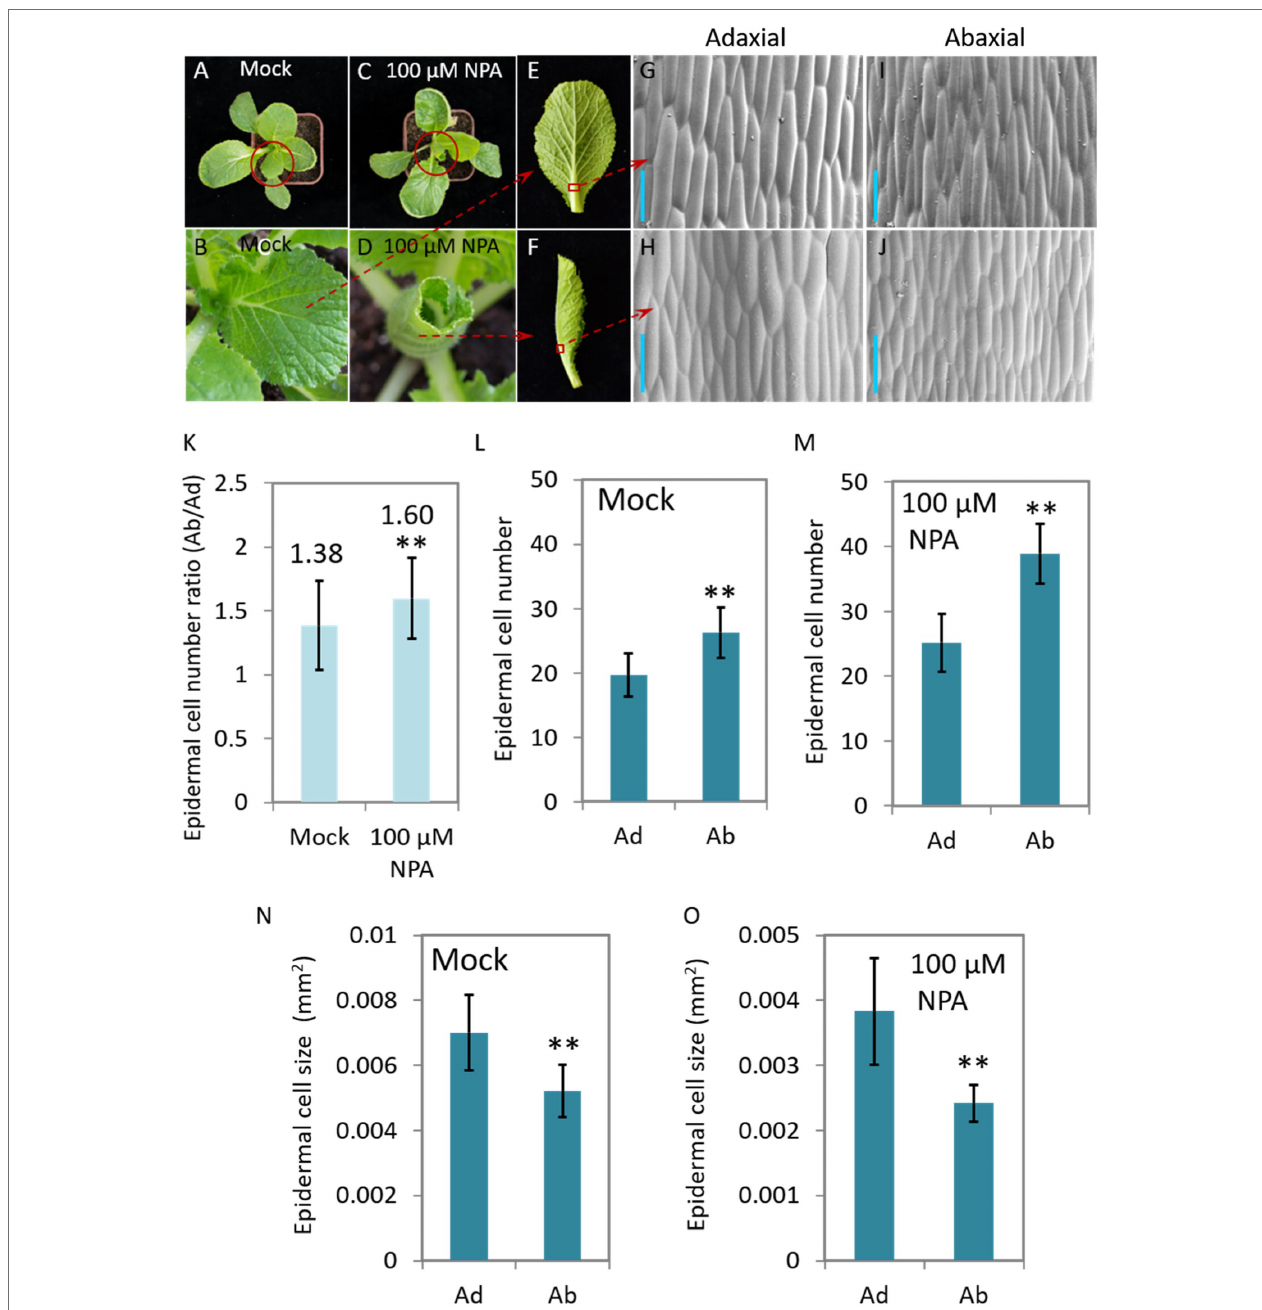
FIGURE 4 | The NPA-mediated interruption of auxin transport leads to leaf curling and asymmetrical growth of abaxial/adaxial vein epidermal cells at seedling stage. Phenotypes of the plants (40-day-old) treated with 100 μ M NPA (C , D , F) and mock (A , B , E) . (B,D) Magnified pictures of the leaves marked with red circles in (A,C) ; (G–J) scanning electron micrographs of the Ab/Ad cells of the midrib parts indicated by the red squares in (E,F) . (K) The cell number ratios (Ab/Ad) of leaf vein epidermis. (L,M) Adaxial and abaxial epidermal cell numbers of the midrib parts displayed in (G–J) . Cell numbers in areas of 0.134 mm 2 (Mock) and 0.093 mm 2 (treated with 100 μ M NPA), respectively, were counted. (N,O) Mean size of the adaxial and abaxial epidermal cells in the midrib parts of the leaf veins displayed in (G–J) . Values are means ± SD ( n = 32–48). Asterisks indicate significant differences using Student’s t -test ** p < 0.01. Scale bars: 100 μ m (G – J) . Ad/Ab, adaxial/